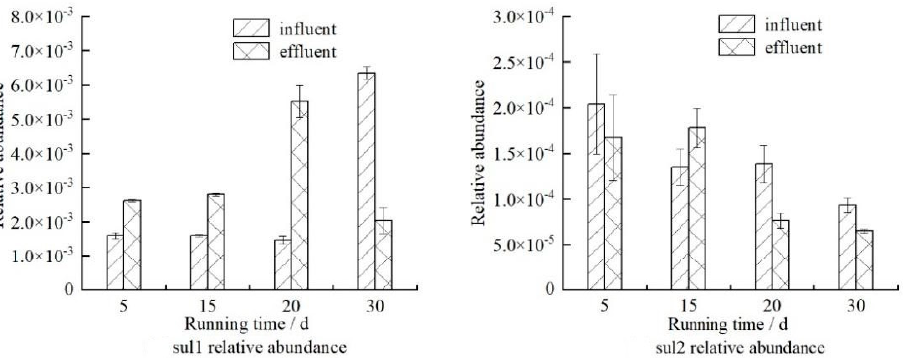
Figure 4. Relative abundance of sulfonamide